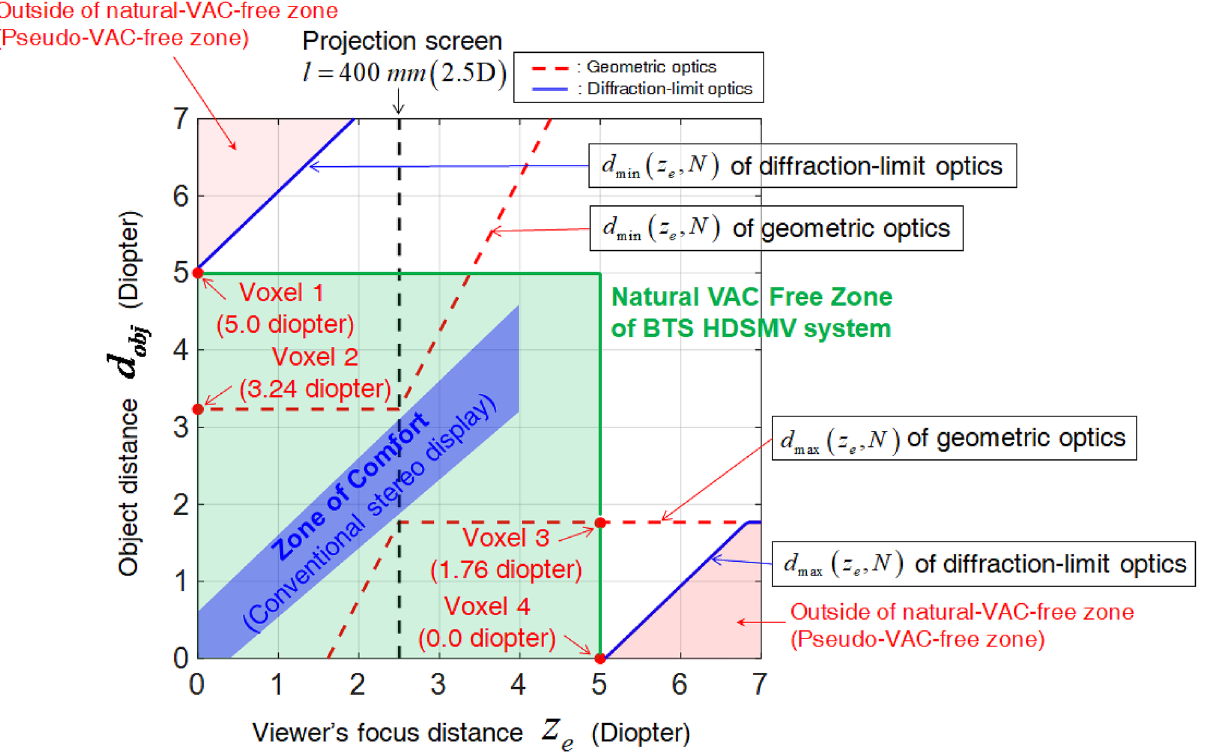
Figure 7. Natural VAC-free zone of the proposed BTS HDSMV